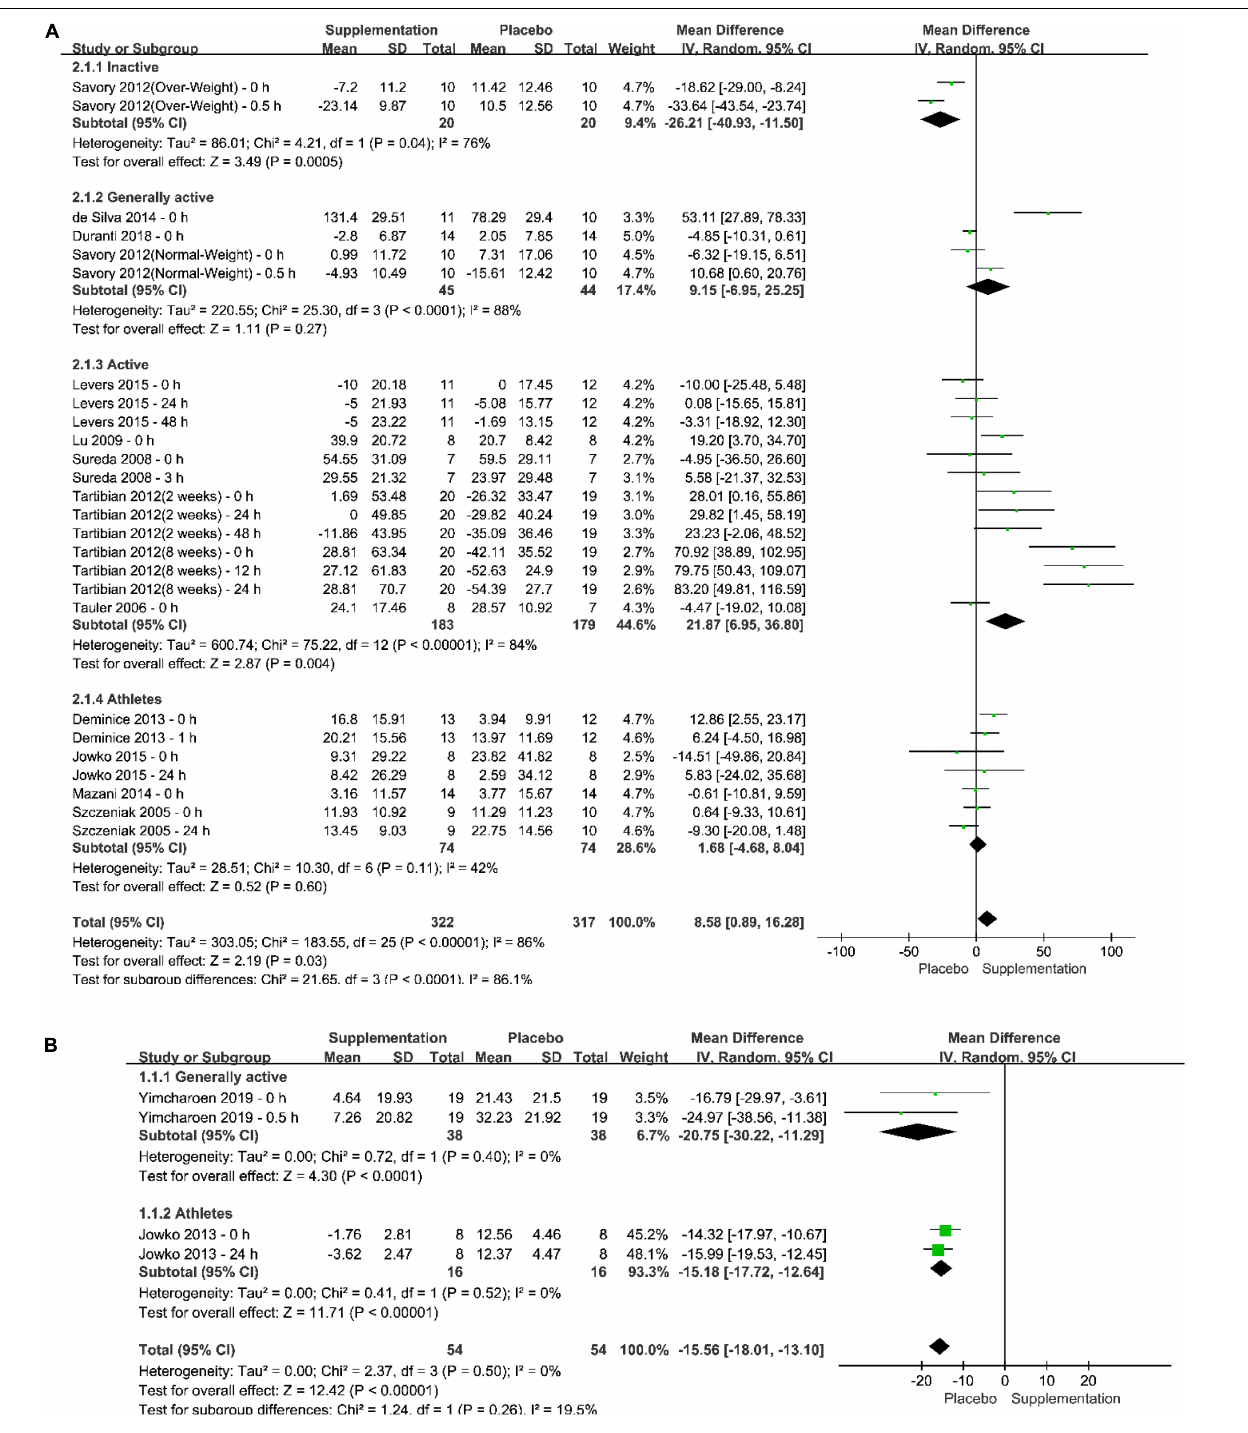
FIGURE 4 | Forest plots of the pooled effect of different supplementation protocols on the increasing plasma superoxide dismutase (SOD) after exercise tests. (A) Long-term supplementation vs. Long-term placebo intake; (B) One-time supplementation vs. One-time placebo